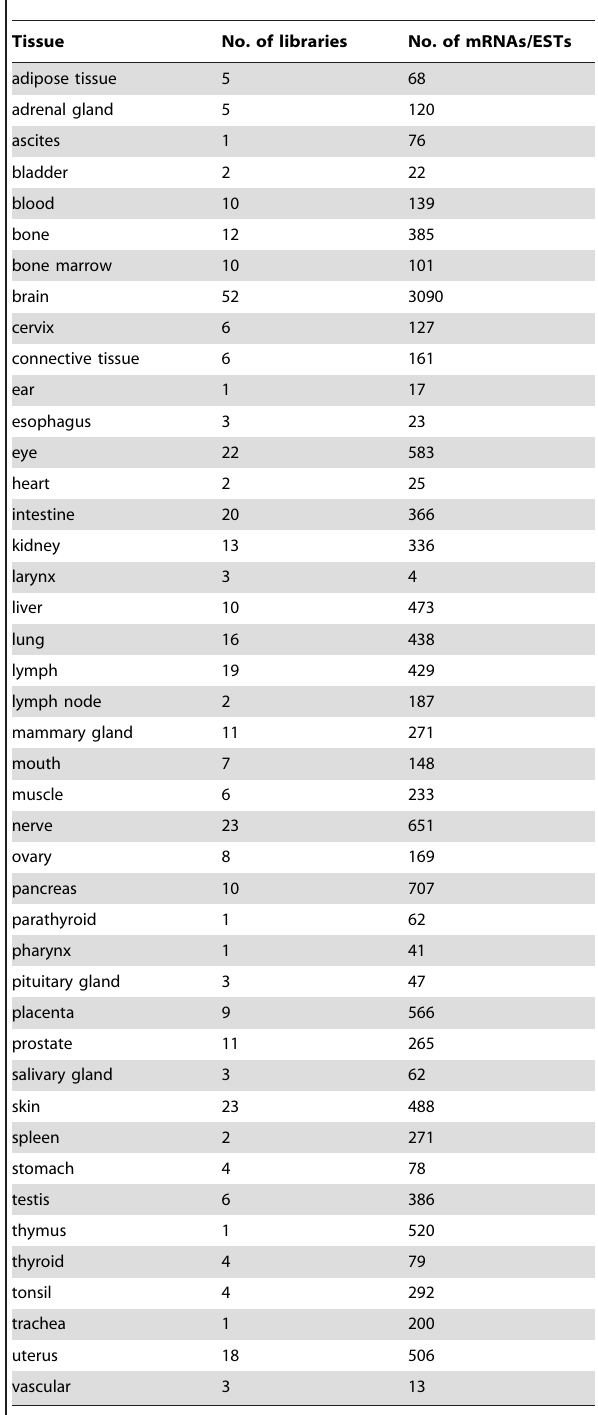
Table 2. Distribution of mRNA/EST sequences and cDNA libraries identified with A-to-I editing sites among 43 tissue